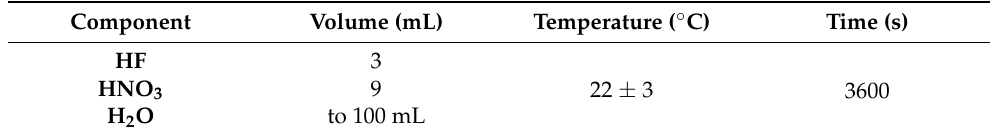
Table 2. Conditions of pickling (acid cleaning).